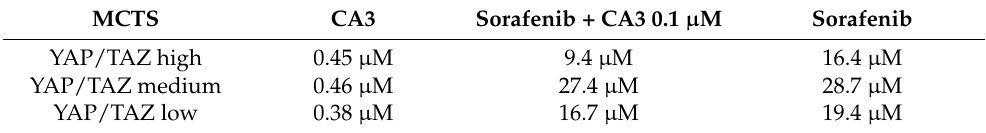
Table 2. Half maximal inhibitory concentrations (IC50) of anti-cancer drugs in patient-derived MCTS.